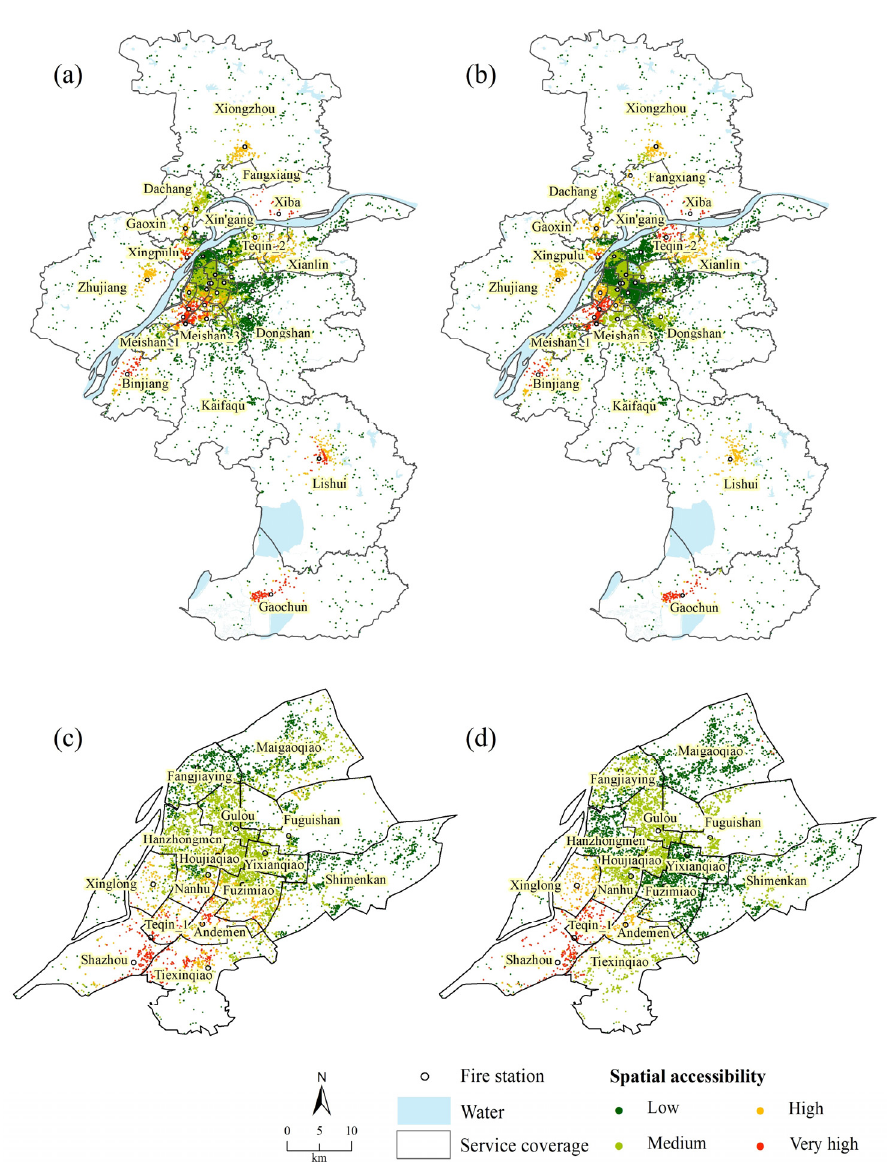
Figure 6. The spatial accessibility of fire incidents using ( a ) E2SFCA and ( b ) FC2SFCA. ( c ) city center of ( a ), ( d ) city center of ( b ).